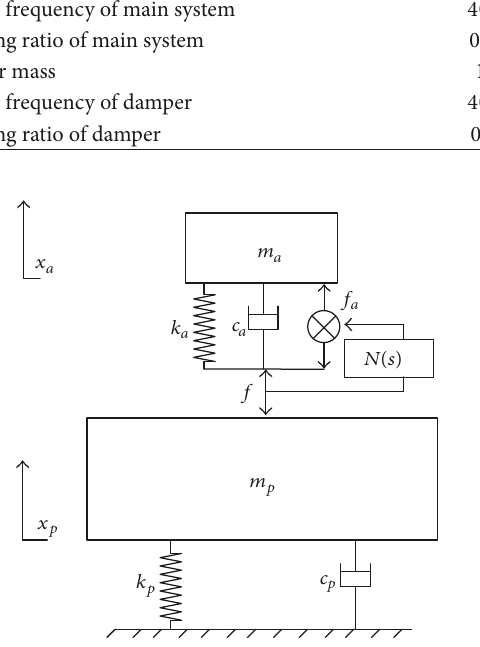
Figure 2: Schematic of the ATMD system.